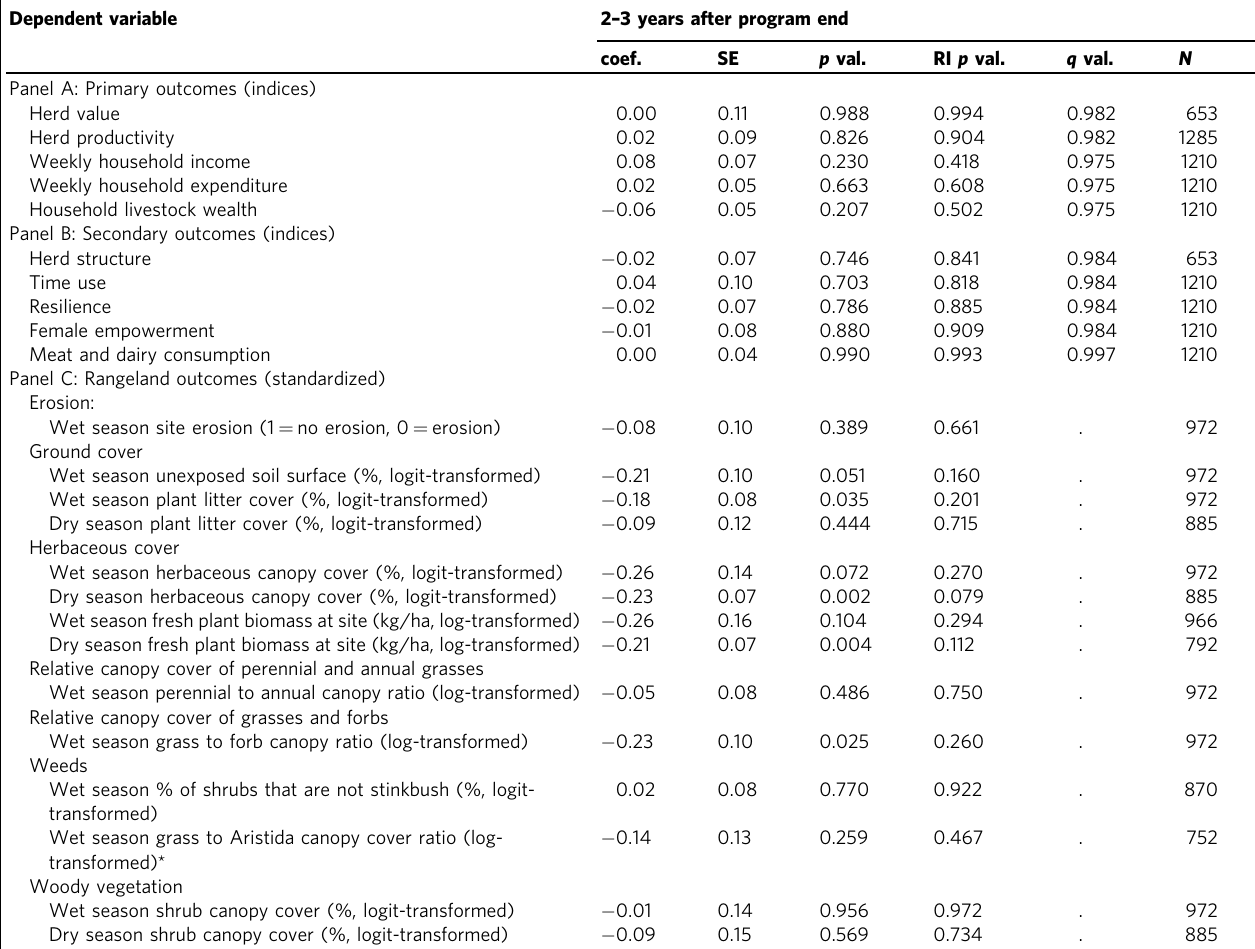
Table 4 Treatment effect on rangeland health, cattle productivity, and household economics. Dependent variable